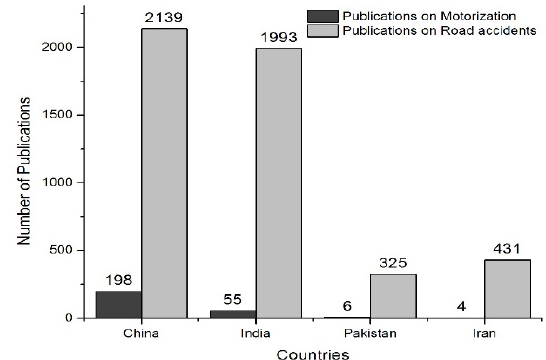
Fig. 1. Number of publications on motorization and